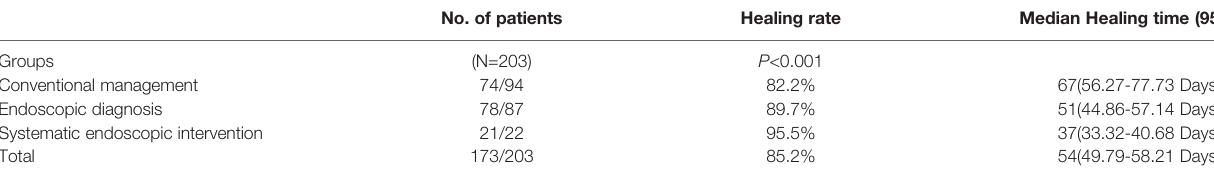
TABLE 4 | Overall healing the 203 patients with EAL.